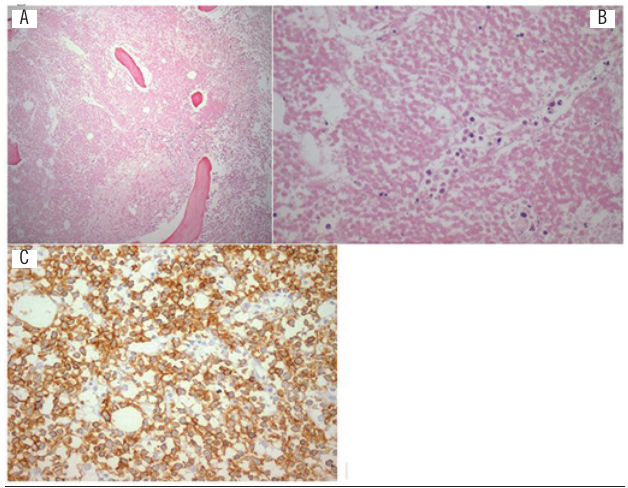
figurE 3 − BM biopsy in BMN: A) BM biopsy of a patient with Burkitt lymphoma showing severe necrosis (HE, 100×); B) BM coagulative necrosis with “ghost” neoplastic cells (HE, 200×); C) CD20 staining, 400× BM: bone marrow; BMN: bone marrow necrosis; HE: hematoxilin and eosin.